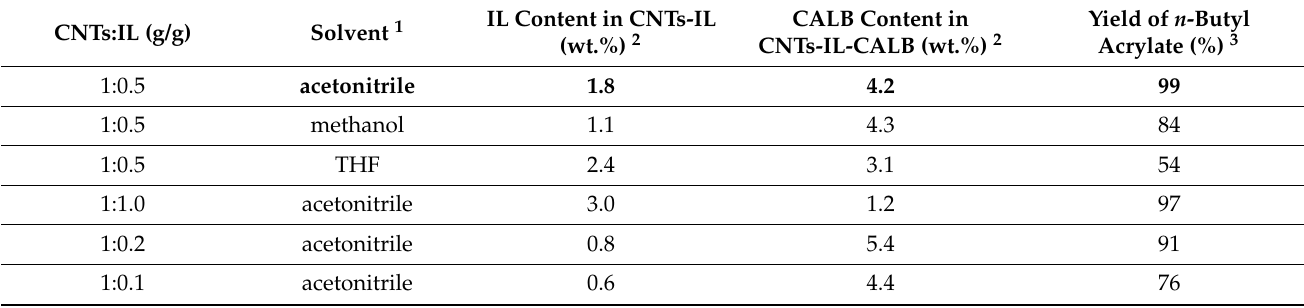
Table 1. The influence of the preparation conditions of CNTs-IL-CALB on the biocatalyst activity.